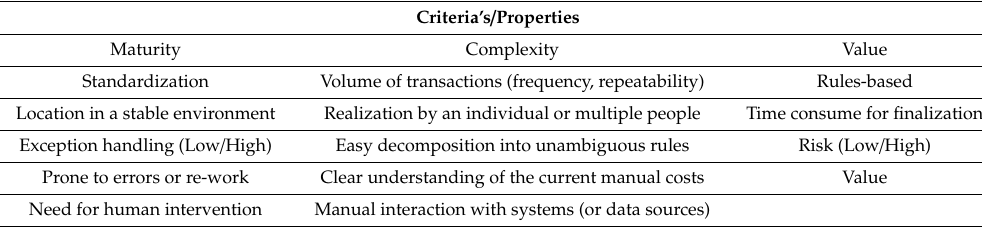
Table 4. Criteria’s and properties for process